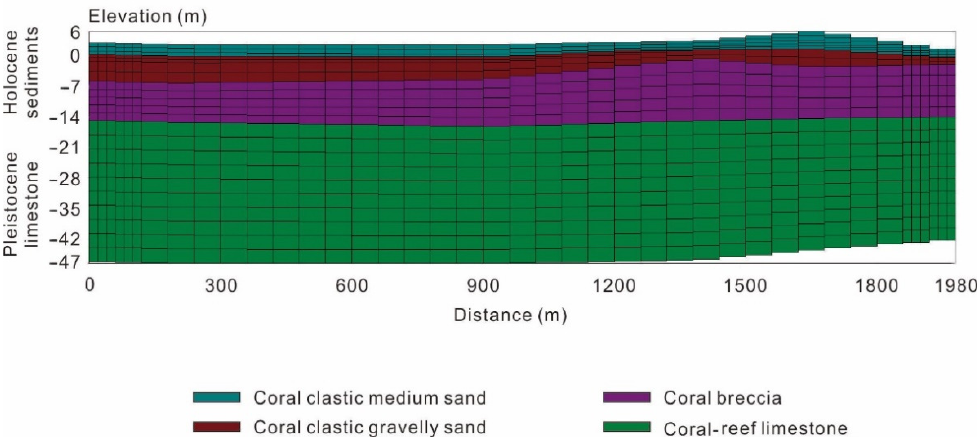
Figure 2. Model gird for the small coral island, divided into a mesh of 902 discrete rectangular elements, for performing simulations of groundwater flow and solute transport within the islet substrate.